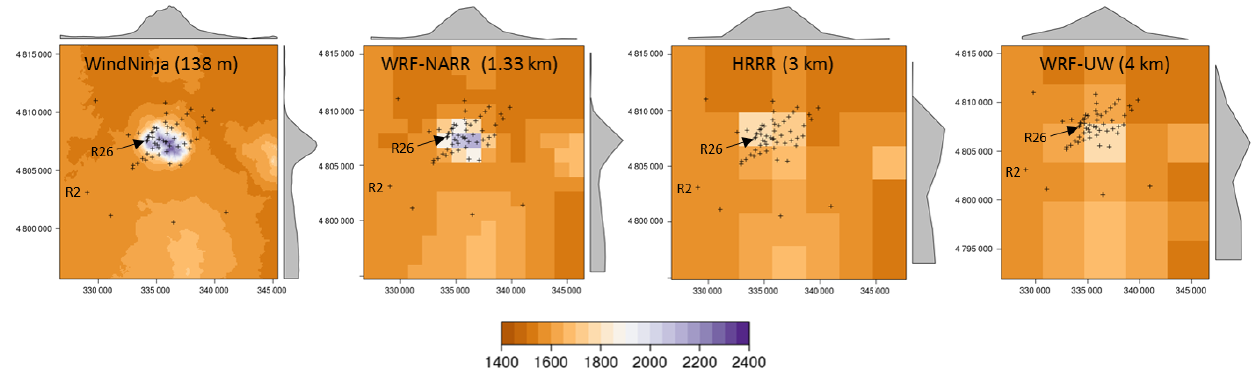
Figure 1. Terrain representation (ma.s.l.) in WindNinja, WRF-NARR, HRRR, and WRF-UW for the Big Southern Butte. Crosses indicate surface sensor locations. Maps are projected in the Universal Transverse Mercator (UTM) zone 12 coordinate system. Axis labels are eastings and northings in m. Profiles in gray are the average elevations for rows and columns in the panel. NAM (12km) terrain is represented by just four cells and is not shown